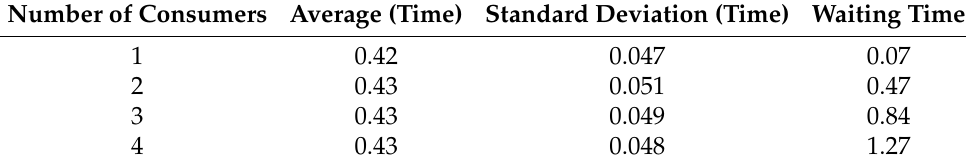
Table 6. Comparison of different consumer performance.